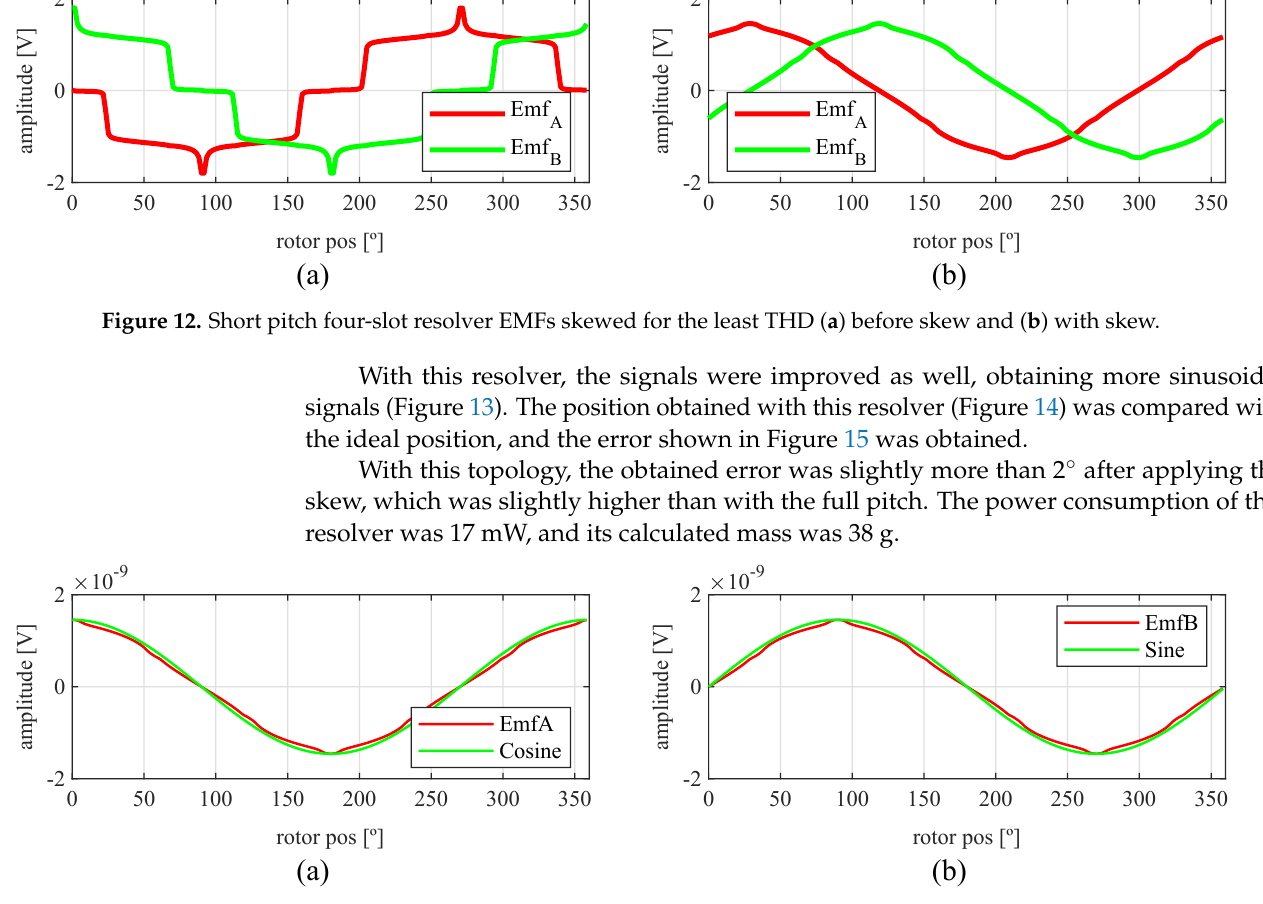
Figure 13. Full pitch four-slot skewed resolver EMFs vs ideal signals ( a ) EMF A vs. Cosine and ( b ) EMF B vs.